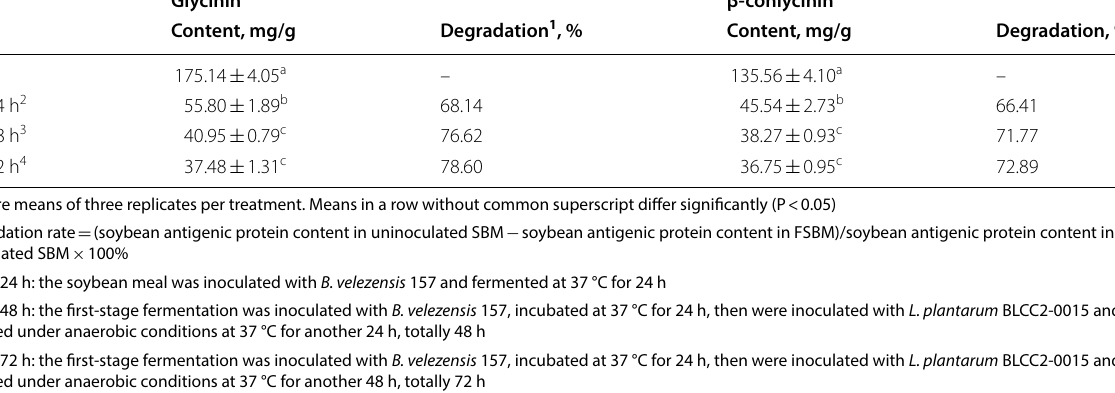
Table 1 Effect of fermentation on the concentration of soybean antigenic protein during two-stage fermentation